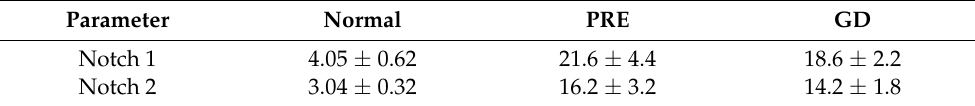
All values are given in ng/mL and are means ± S.E.M. (significantly diff. from controls, ANOVA, p <